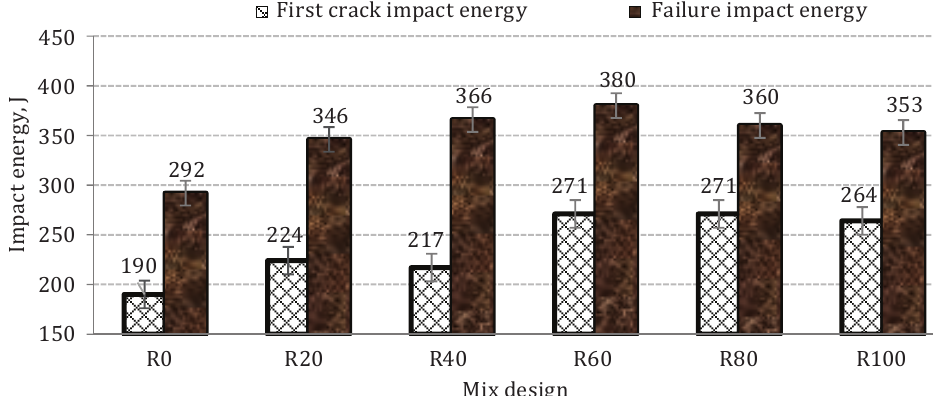
Figure 6. Impact strength of the